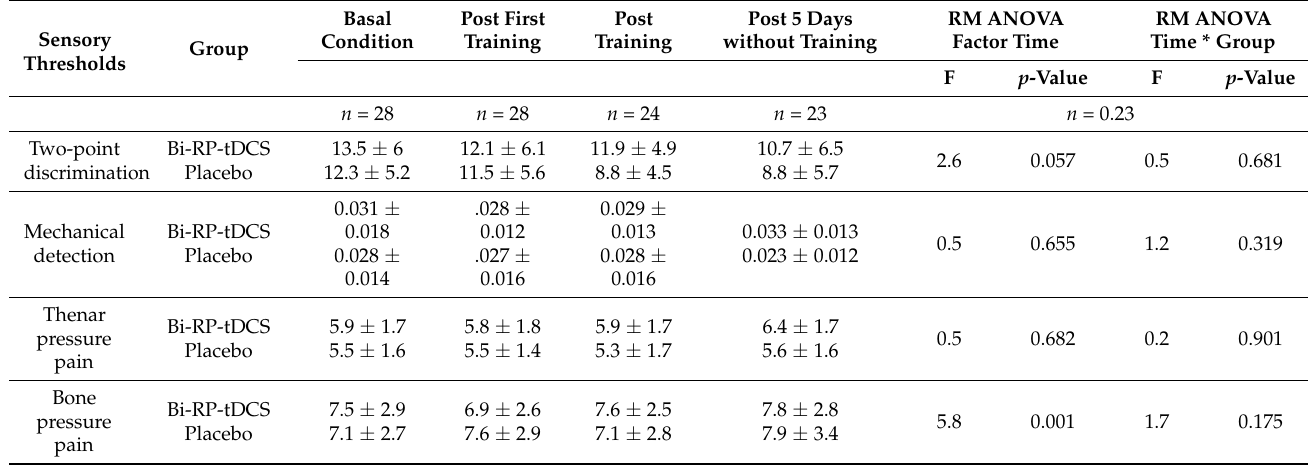
Table 4. Training and bi-RP-tDCS effects on sensory variables (mean ± SD).